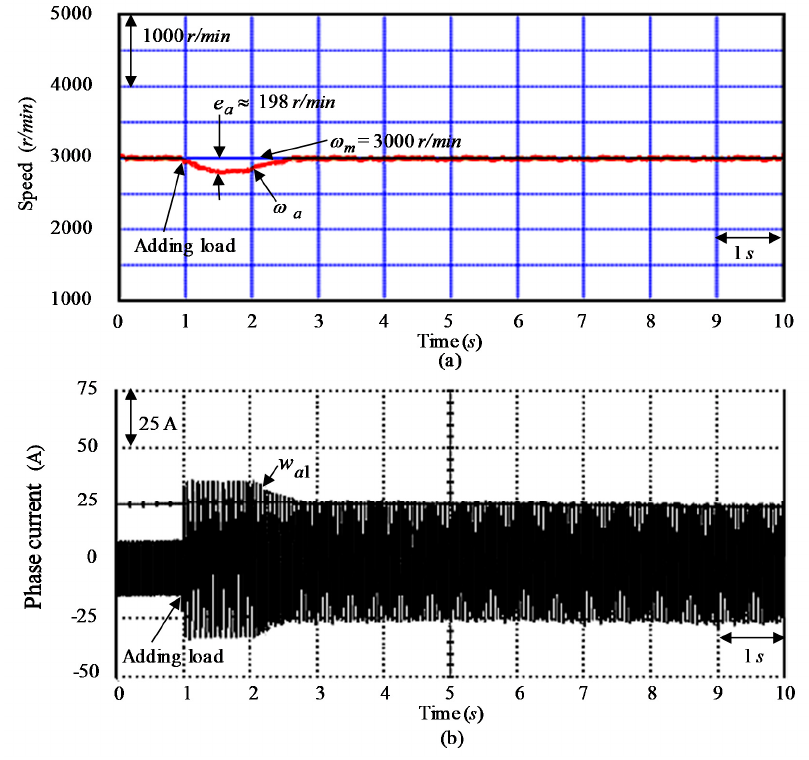
Figure 18. Tested results at the tested Event E3 case by using the controller CT2: ( a ) speed-adjusted response; ( b ) current response in phase a.